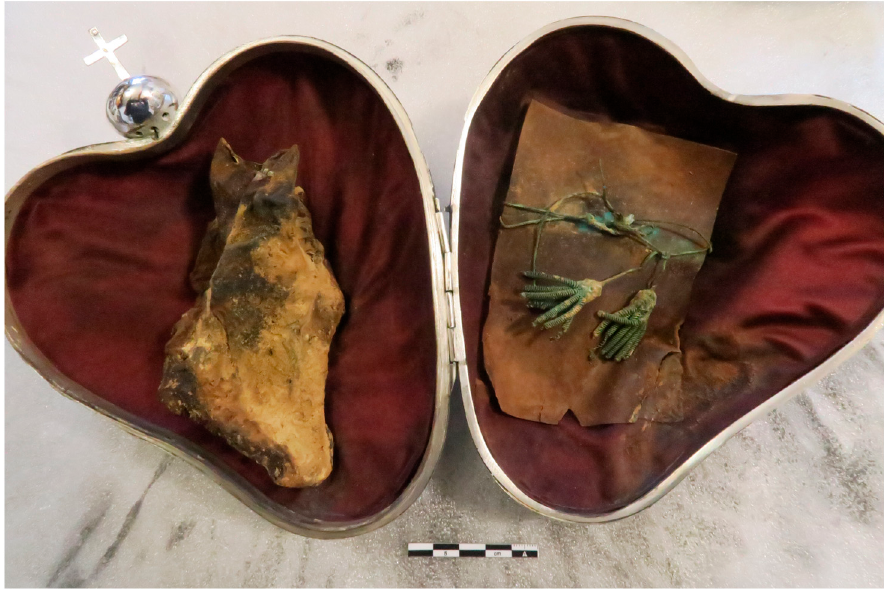
Figure 1. Heart of P. Jaricot at the opening of the silver cardiotaphe; on the right, cellulosic element (cardboard) and cardinal tassels .